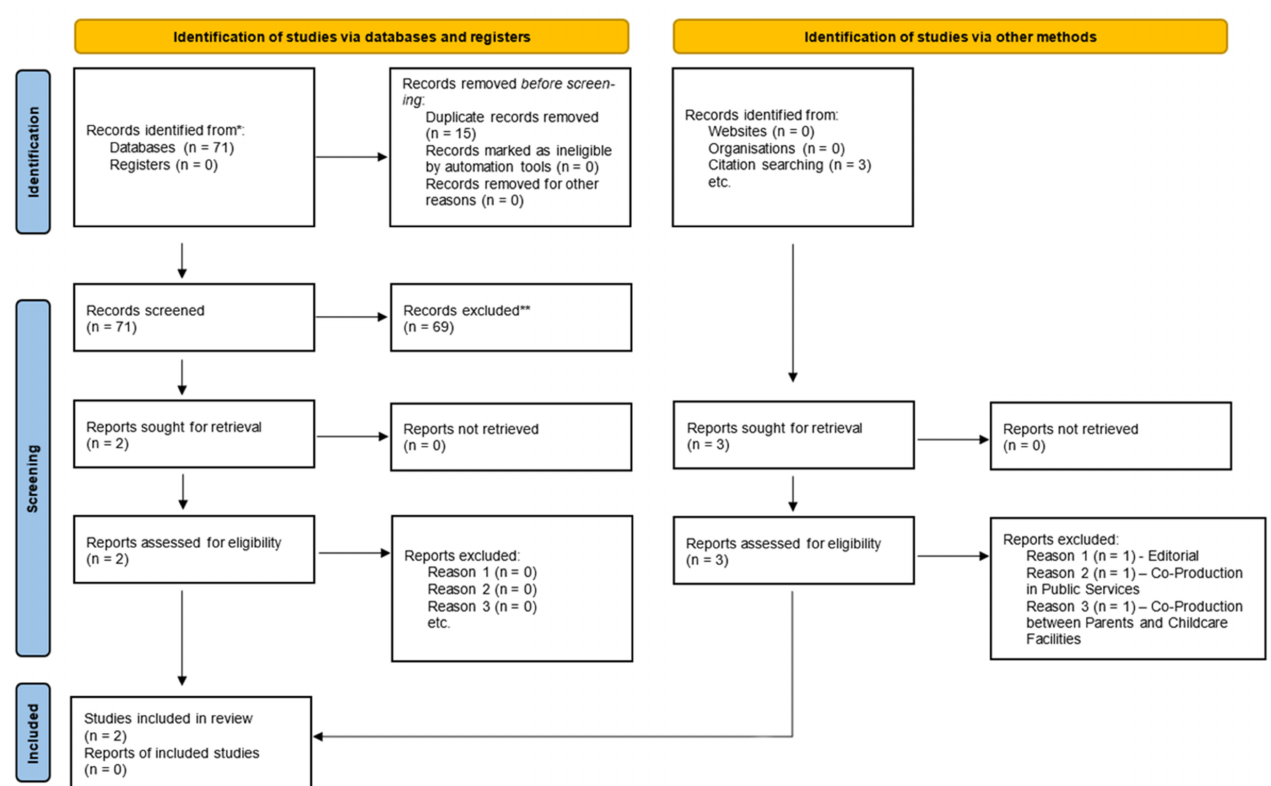
Figure 3. PRISMA (2020 Edition) Flow Chart. Please note that full reasons for exclusion of studies can be found in Appendix